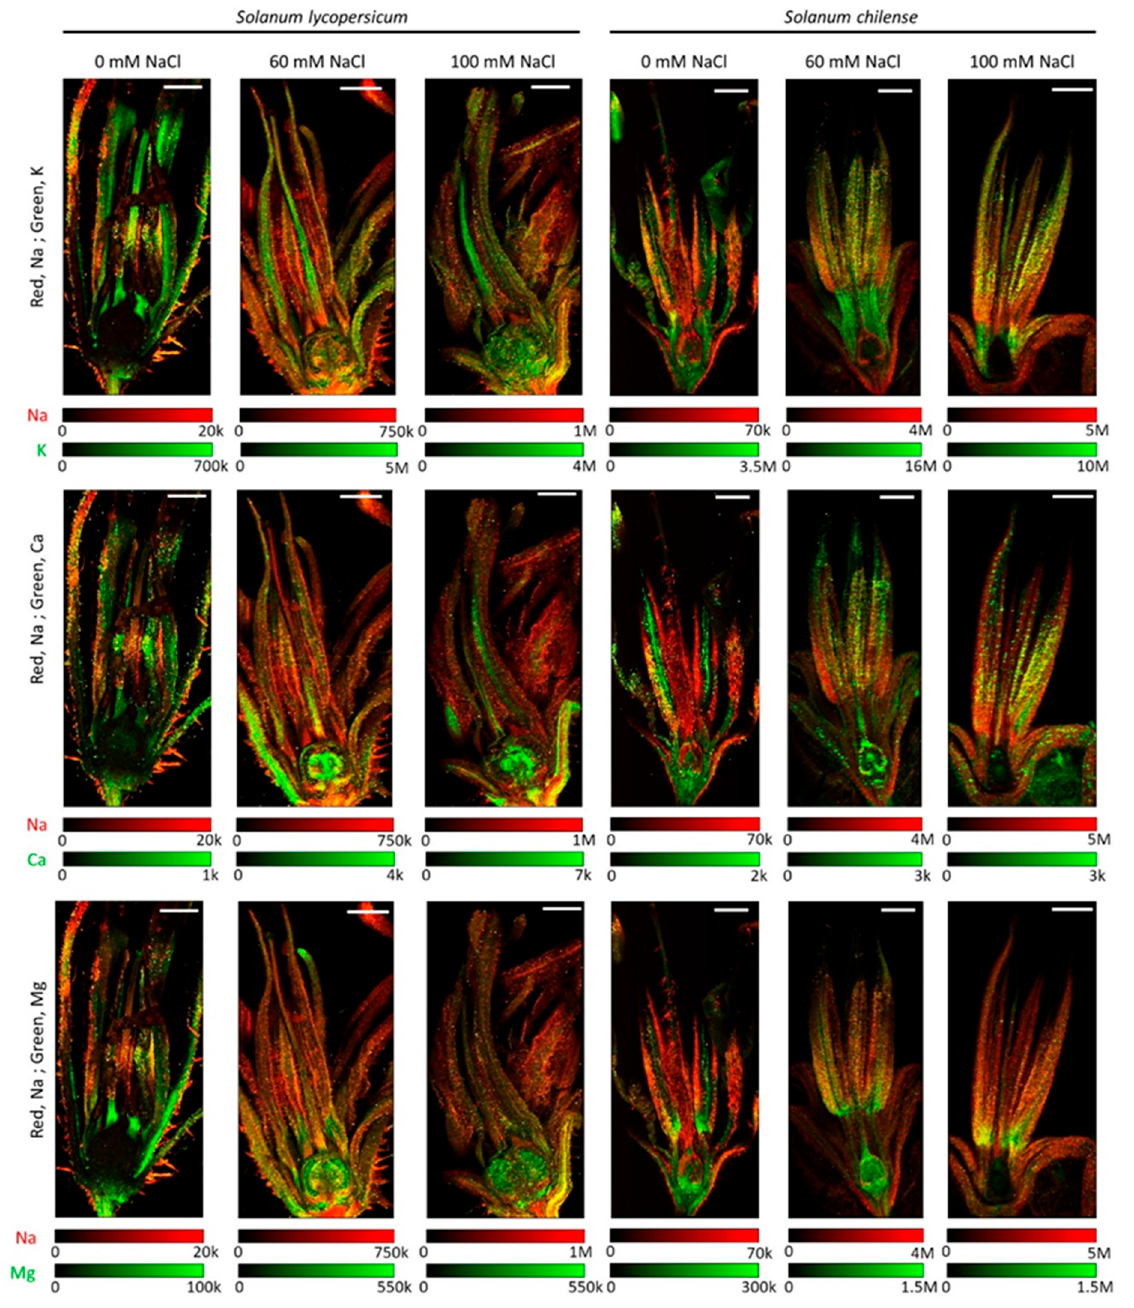
Figure 4. Distribution of sodium (Na) shown in red and potassium (K), calcium (Ca) and magnesium (Mg) shown in green and their co-localization (yellow) in flowers of Solanum lycopersicum and Solanum chilense grown in perlite:vermiculite mixture supplied with 0, 60, and 100 mM NaCl. Distribution of individual element was determined using LA-ICP-MS (laser ablation inductively coupled plasma mass spectroscopy) and visualized using ImageJ (version 1.53a). Color legends represent the number of counts per pixel (20 × 20 µm²) for each analysis and each element. Signal intensities are correlated with the concentrations of a particular element. Scale bar = 1000 µm.